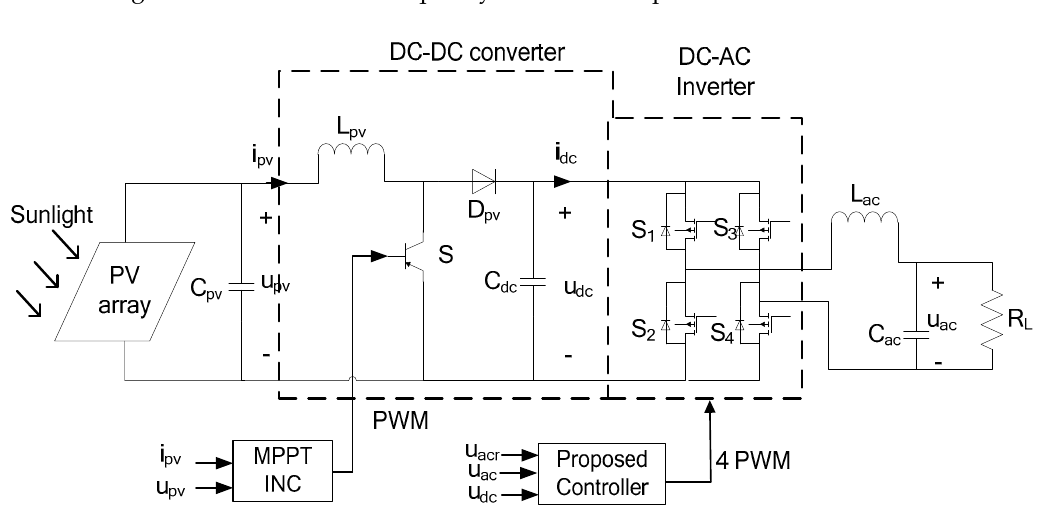
Figure 8. Simulink model of the grid-connected PV inverter.